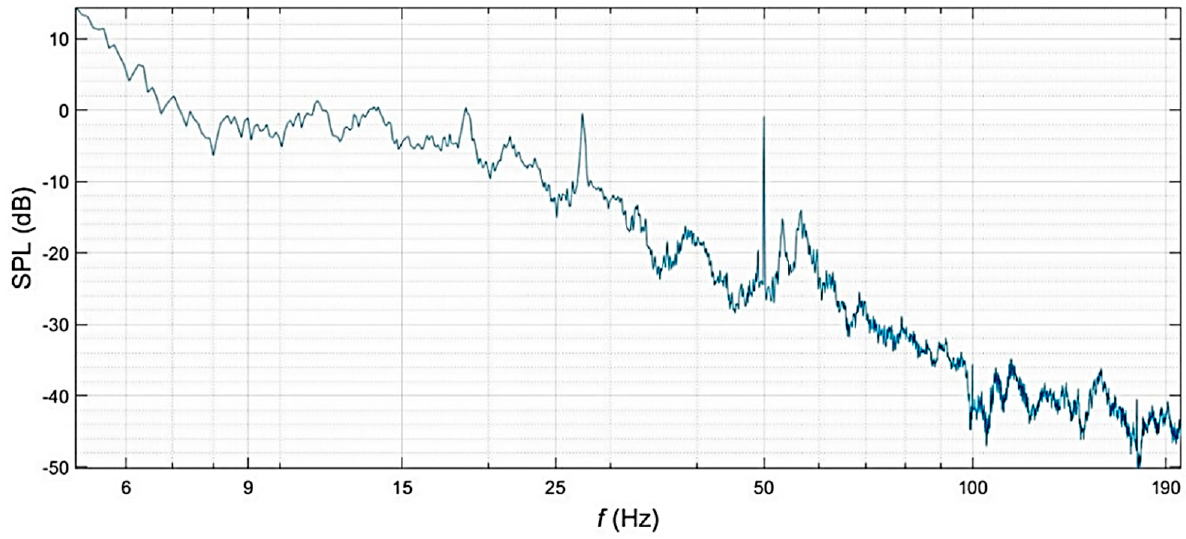
Figure 9. Example of a SPL graph, calculated for the background noise measured at ST_1.